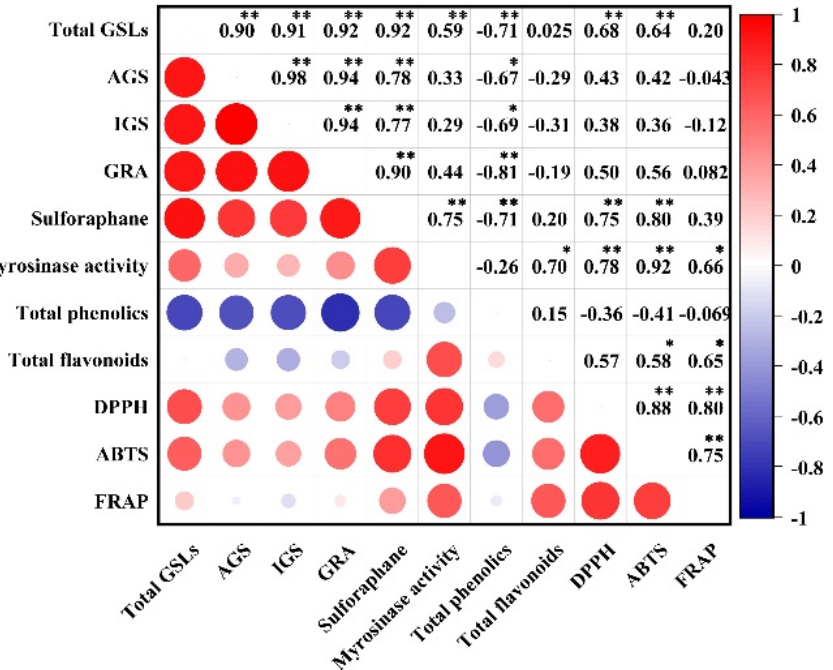
Figure 7. Pearson correlation analysis of bioactive substances and antioxidant activity broccoli florets of two cultivars. GSLs: glucosinolates; AGS: total aliphatic GSLs; IGS: total indole GSLs; GRA: glucoraphanin; DPPH: 2,2-di-phenyl-1-picrylhydrazyl radical scavenging capacity; ABTS: trolox-equivalent antioxidant capacity; FRAP: ferric-reducing antioxidant power. * and ** represent significant correlation at the 0.05 and 0.01 level (2-tailed), respectively.